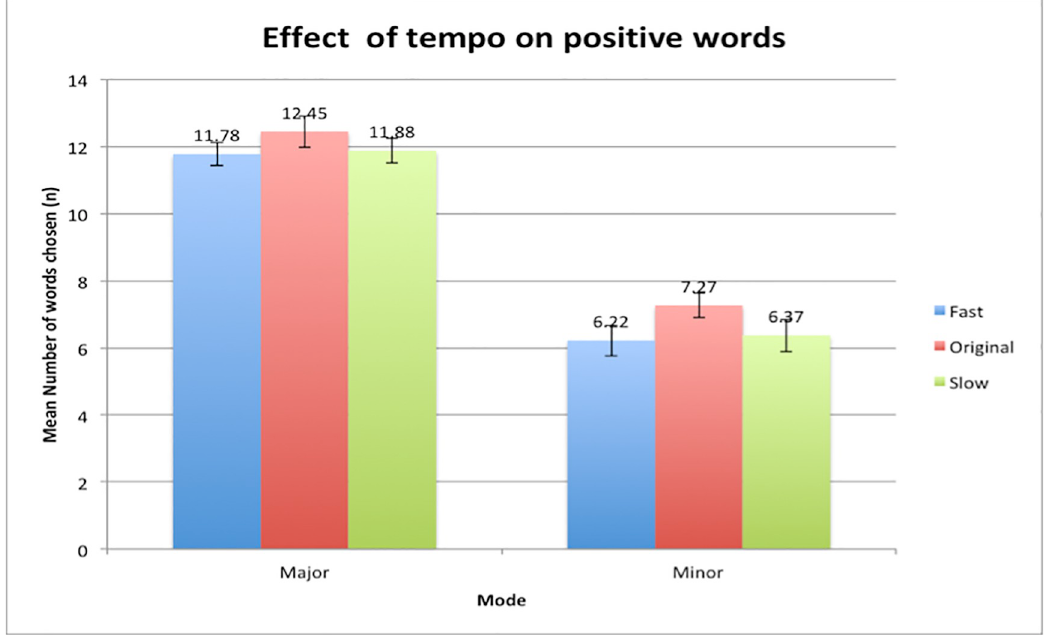
Fig 8. Mean number of positive words selected with respect to the various tempo conditions in both major and minor mode. Error bars indicate the standard error of the mean.